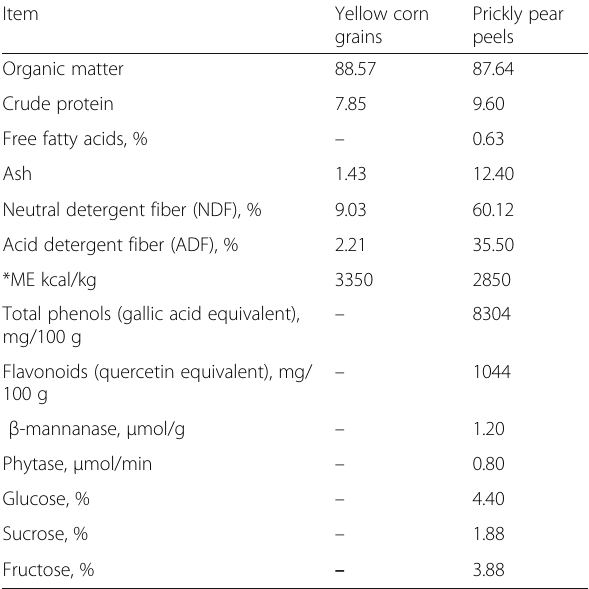
Table 2 Calculated nutrients composition and metabolic energy (ME*) of the main ingredients and the experimental rations